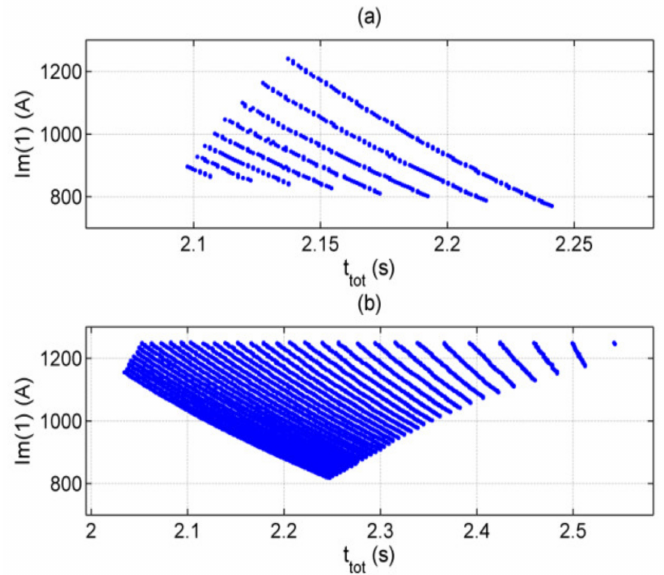
Figure 12. The relationship between the first peak value of the charging current and the total charging time for the two battery pack structures in the feasible solutions of the Enumeration algorithm, respectively. ( a ) N = 25. ( b ) N =